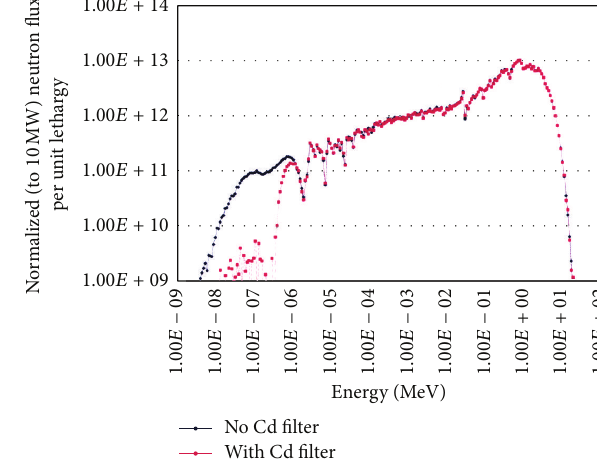
Figure 6: Neutron flux inside the HICU experiment computed for four conditions: with and without neutron screen, with natural Li (7.5% 6Li), and with Lithium-enriched material (30% 6Li) [5].